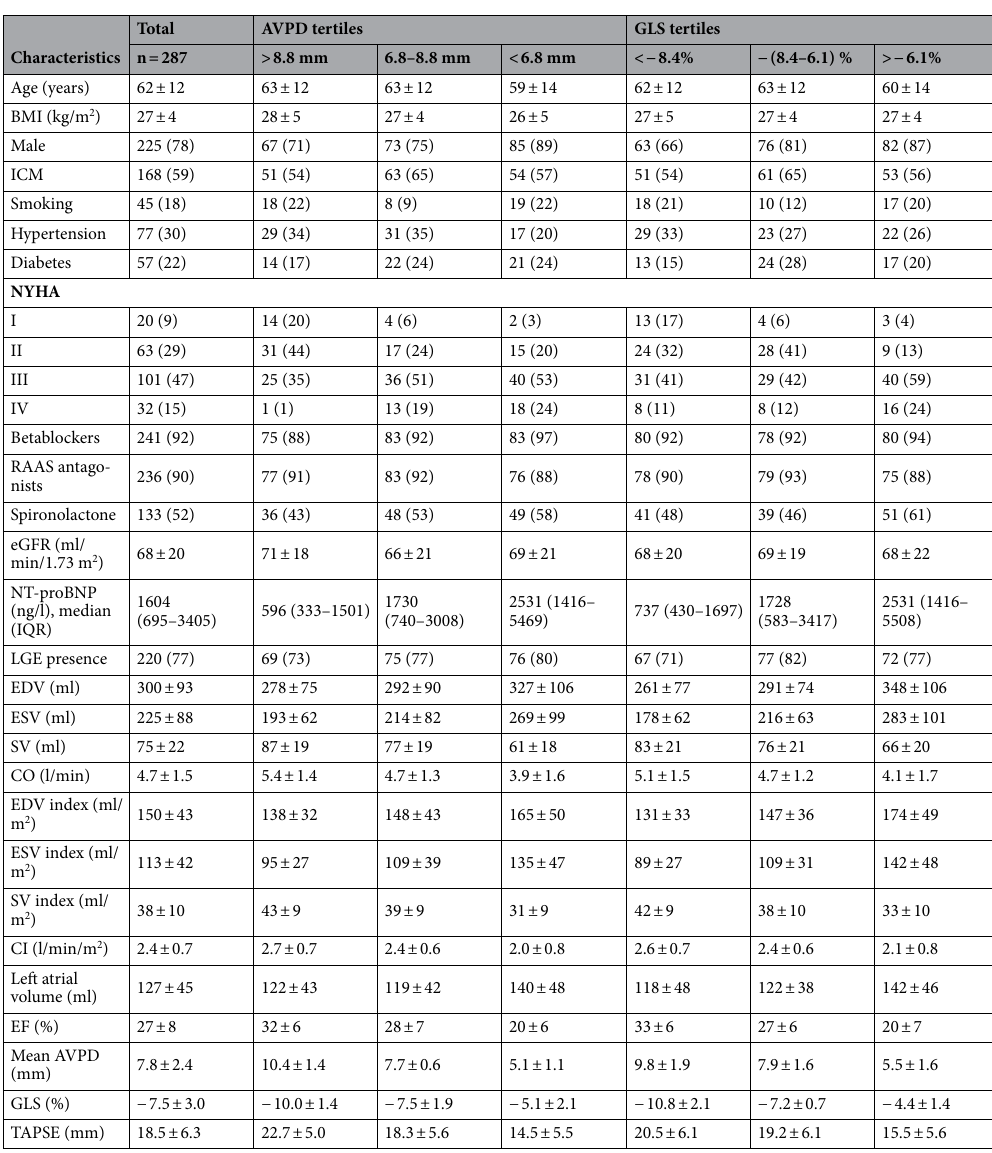
Table 1. Baseline characteristics stratified by AVPD and GLS tertiles. Data are expressed as mean ± standard deviation or as absolute numbers and percentages in parentheses unless otherwise stated. BMI body